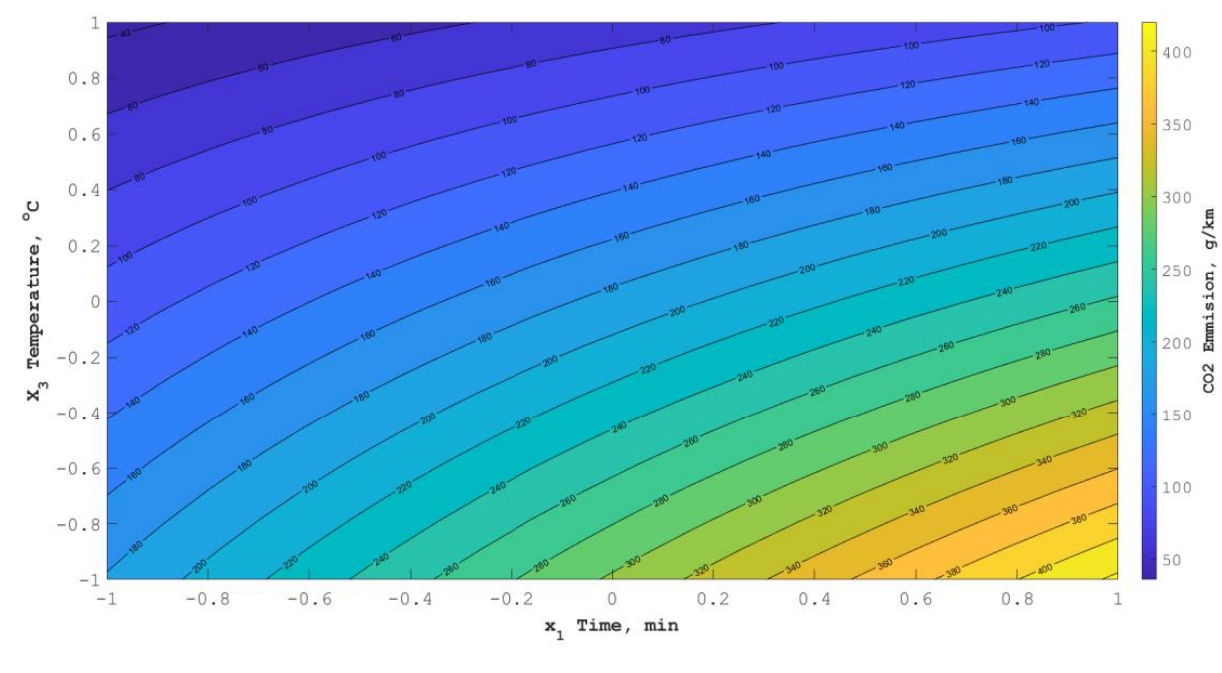
Figure 15. Change of CO 2 emissions depending on the variability of factors x 1 and x 3 for a vehicle (EV) covering a distance of 3 km (x 2 = 0).